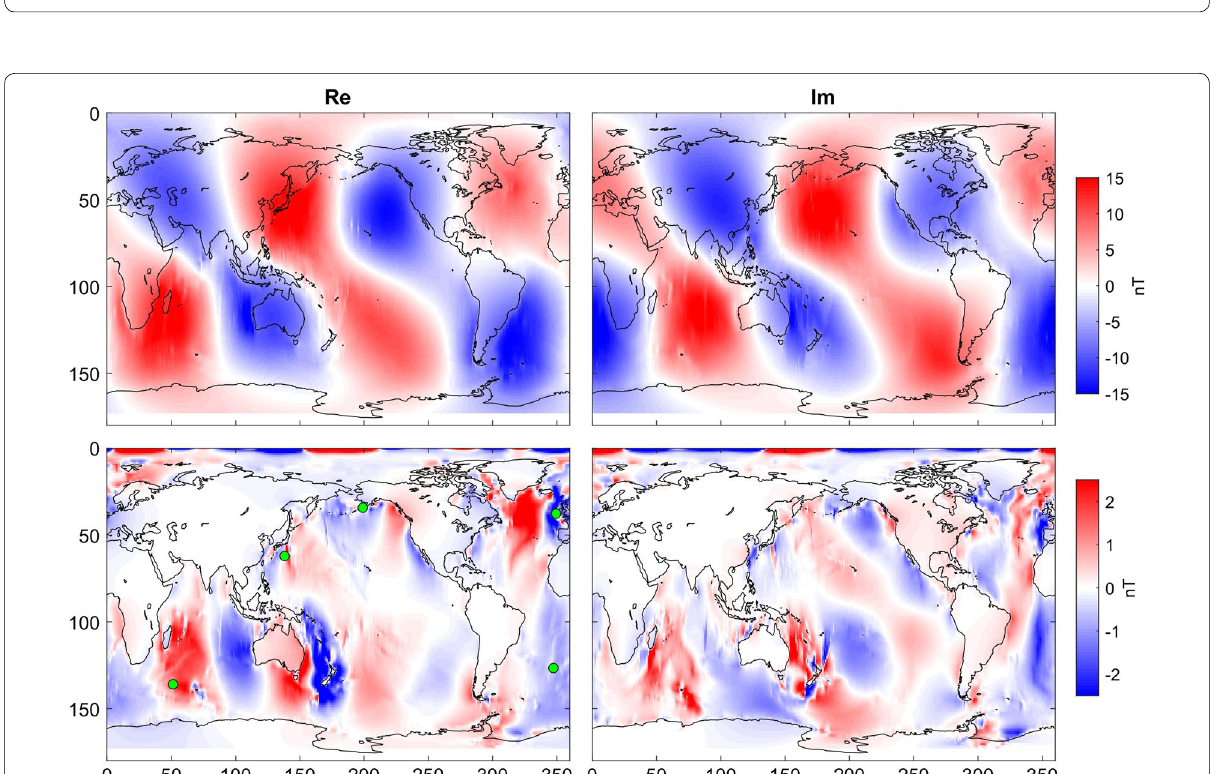
Fig. 8 Modeled Y component at a period of 12 h at the sea level. Top and bottom are the Sq and tidal field, respectively. Left and right are the real and imaginary parts, respectively. Note the different scales for top and bottom